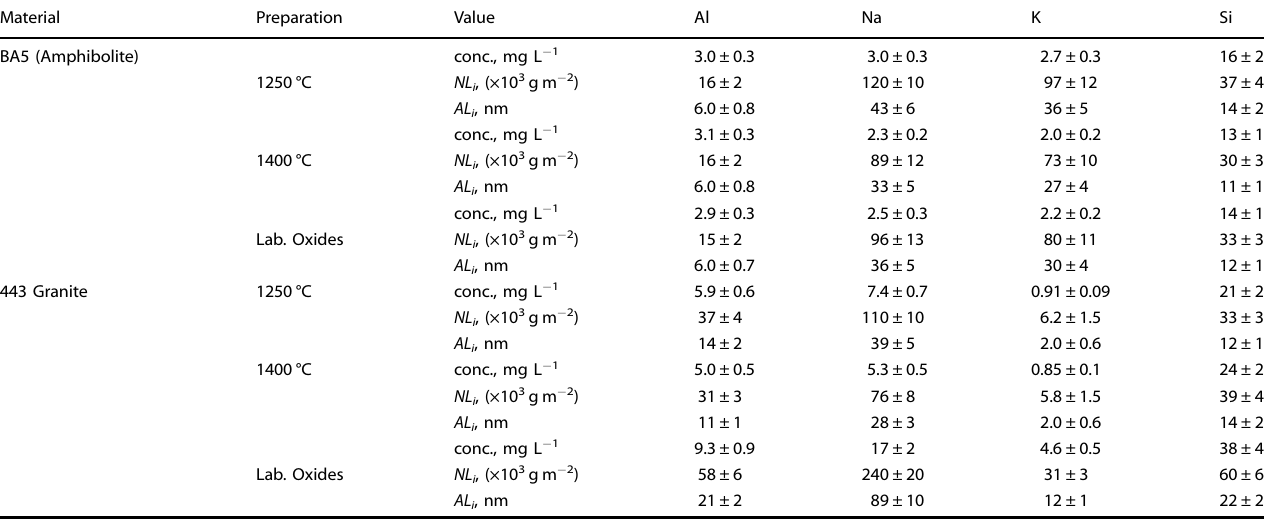
Table 3. Concentrations, NL i values, and alteration depth results from 7-day PCT (average of duplicate samples) for different materials used in this study (Dike excluded). Material